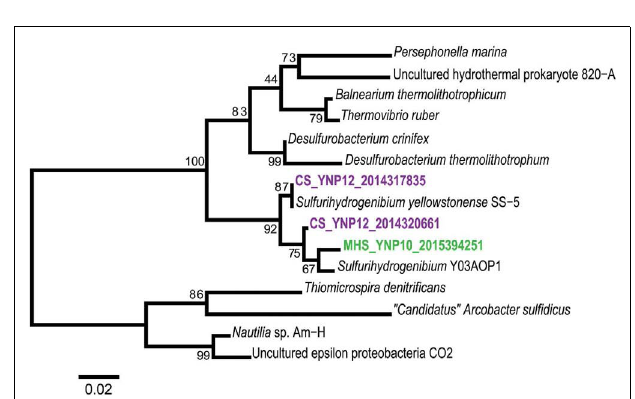
FIGURE 7 | Deduced protein tree ofATP citrate lyase (AclB), a key marker for CO 2 fixation via the reverse-TCA cycle found